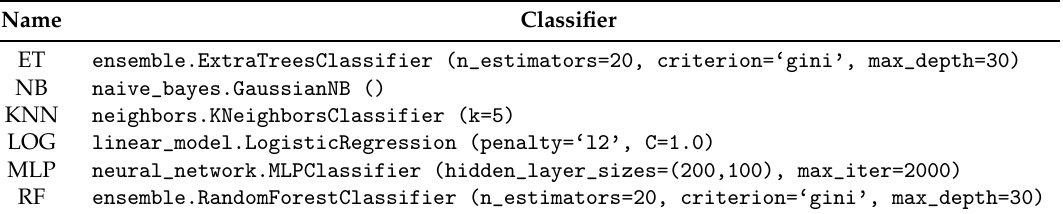
Table 2. Classifiers used in scikit-learn along with the values set for their